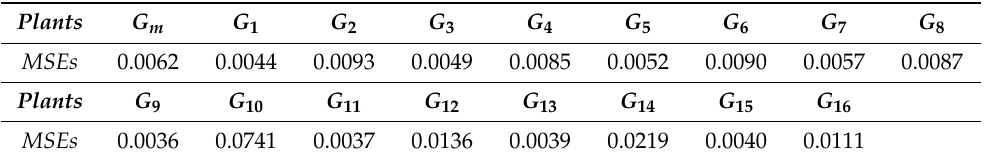
Table 2. Mean squared error (MSE) values of step responses for the FOPID control of 16 plant functions and the nominal plant function G m .